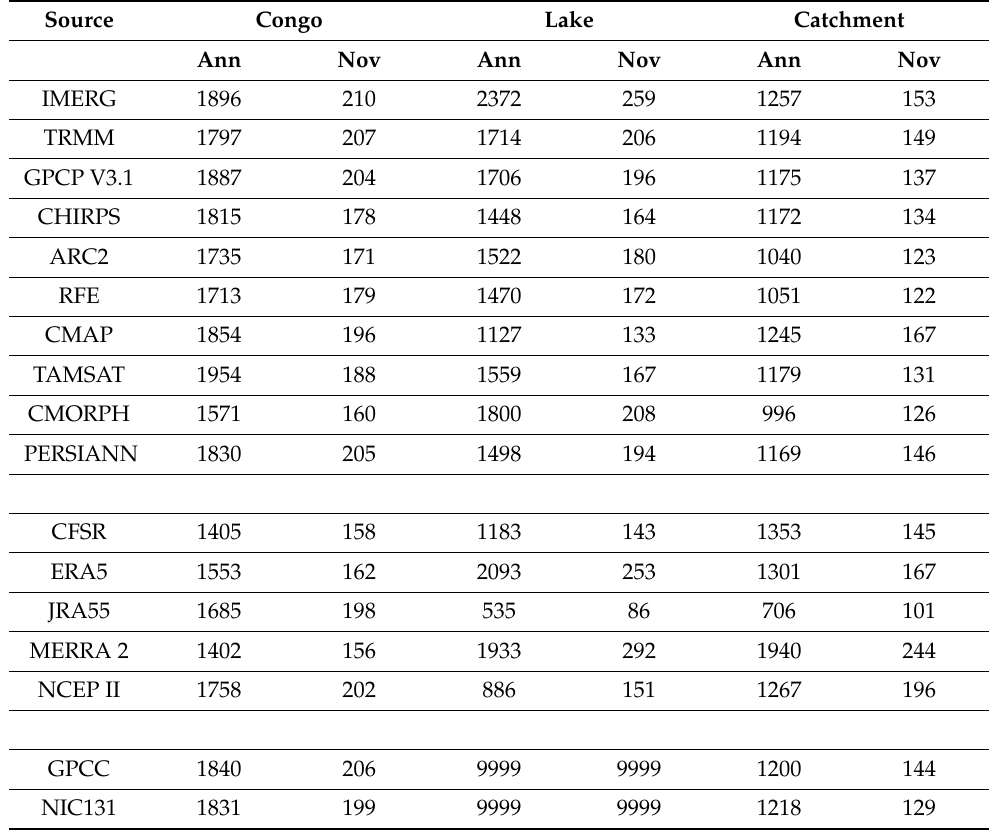
Table 3. Mean annual and November rainfall for the three locations shown in Figure